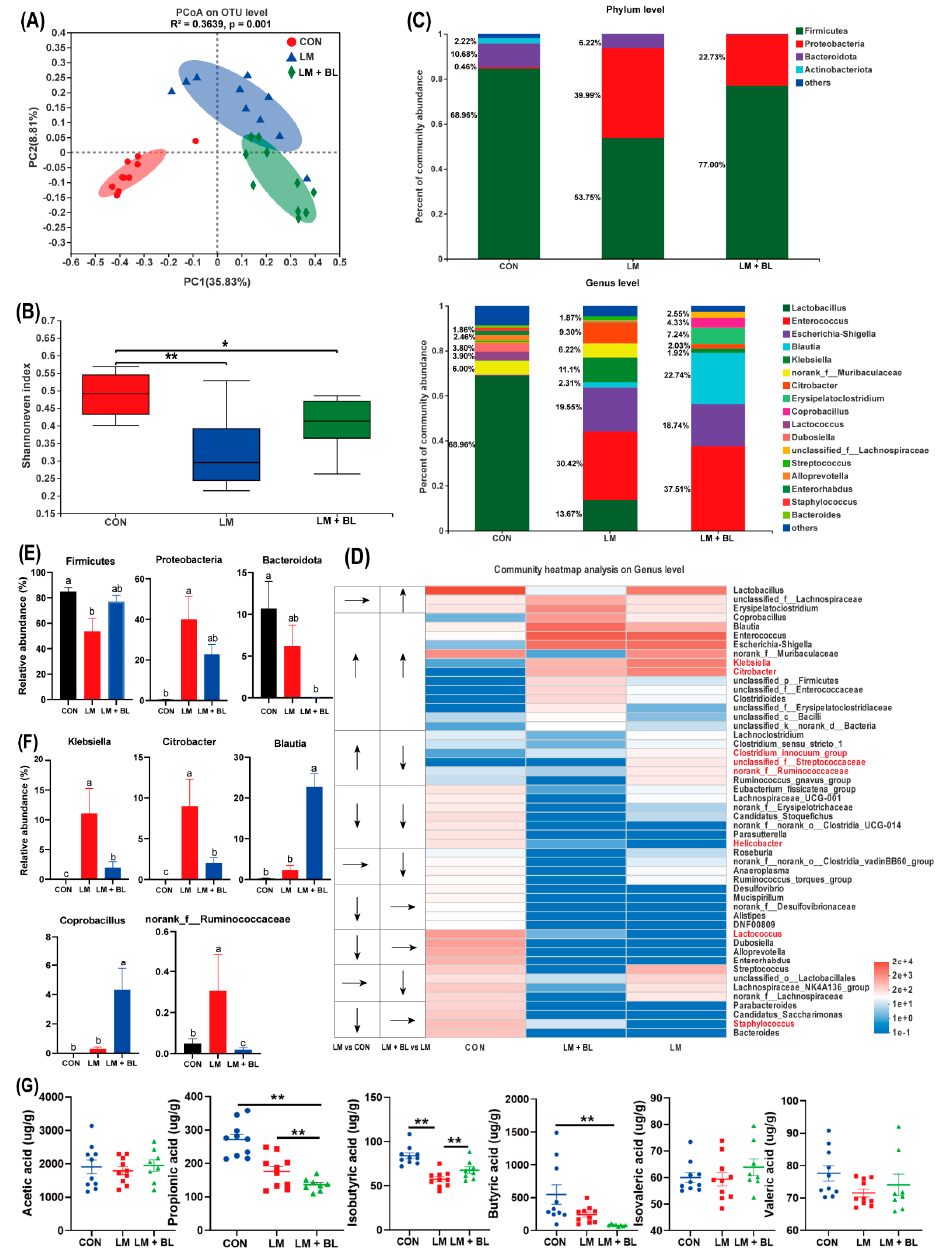
Figure 6. Colon microbiome. ( A ) PCoA analyze. ( B ) Alpha-diversity of fecal microbiota in colon chyme of Shannoneven index. ( C ) Relative abundance of microbiota at the phylum level and genus levels. ( D ) Heat map and trend of bacterial at the genus level. ( E ) Phylum level bacterial statistical comparison in three groups. ( F ) Genus level bacterial statistical comparison in three groups. ( G ) Scatter plot for short-chain fatty acid concentration in colon contents ( n = 10 in CON and LM, n = 8 in LM + BL). Intergroup difference test was performed by Wilcoxon rank-sum test. * means statistically significant ( p < 0.05), ** means p < 0.01. Less than 1% abundance of the phyla or genus was merged into others. Different letters indicate significant differences between the two groups ( p < 0.05), while the same letter indicates insignificant differences ( p >